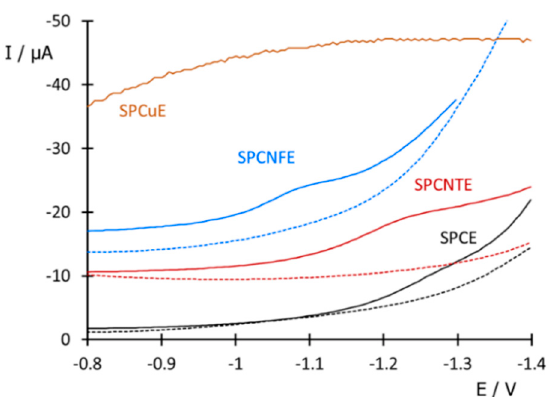
Figure 2. Differential pulse voltammetry (DPV) voltammograms measured for a BZT solution of 5 mg L − 1 at pH 2.2 with screen-printed electrodes made of carbon (SPCE), carbon nanofibers (SPCNFE), carbon nanotubes (SPCNTE), and copper (SPCuE). Dashed lines show the corresponding measurements for a blank solution.